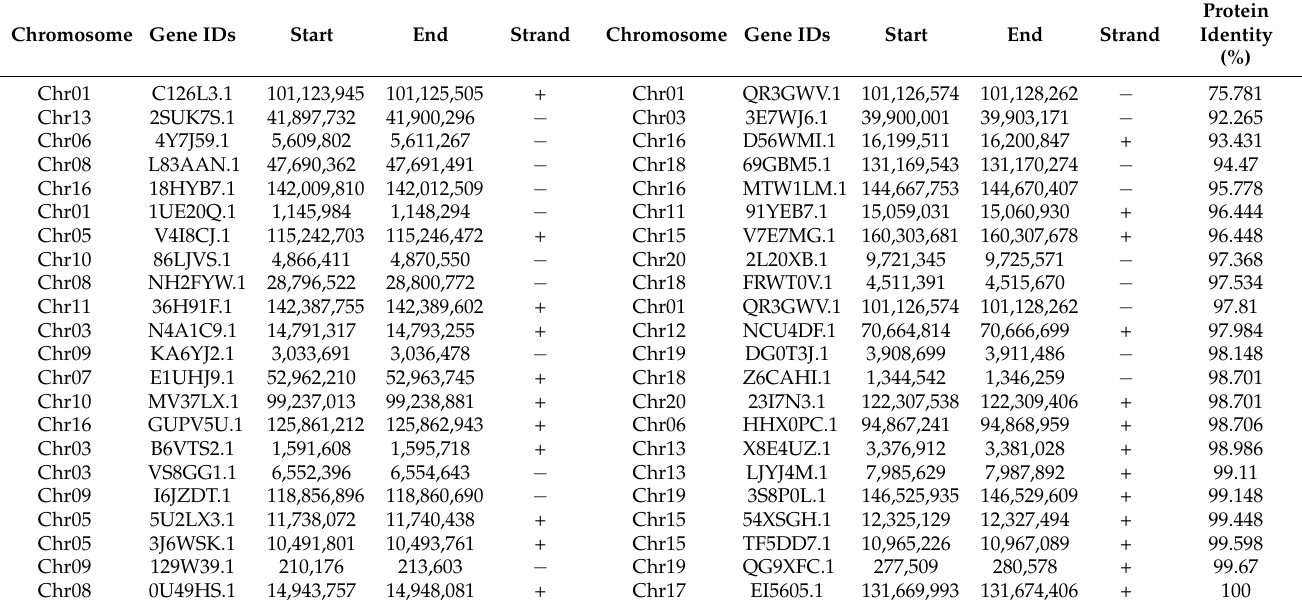
Table 2. Paralogs of GATA family genes in Arachis hypogaea L.